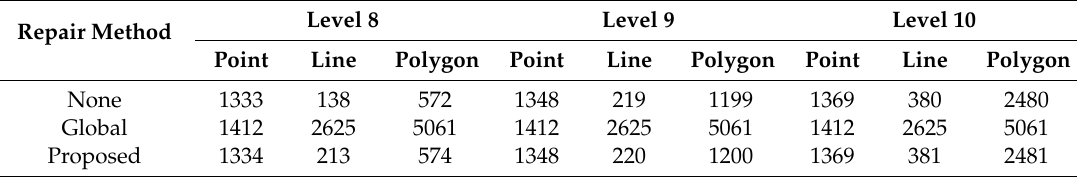
Table 3. Data volume of the gridding results of the three methods (kB).